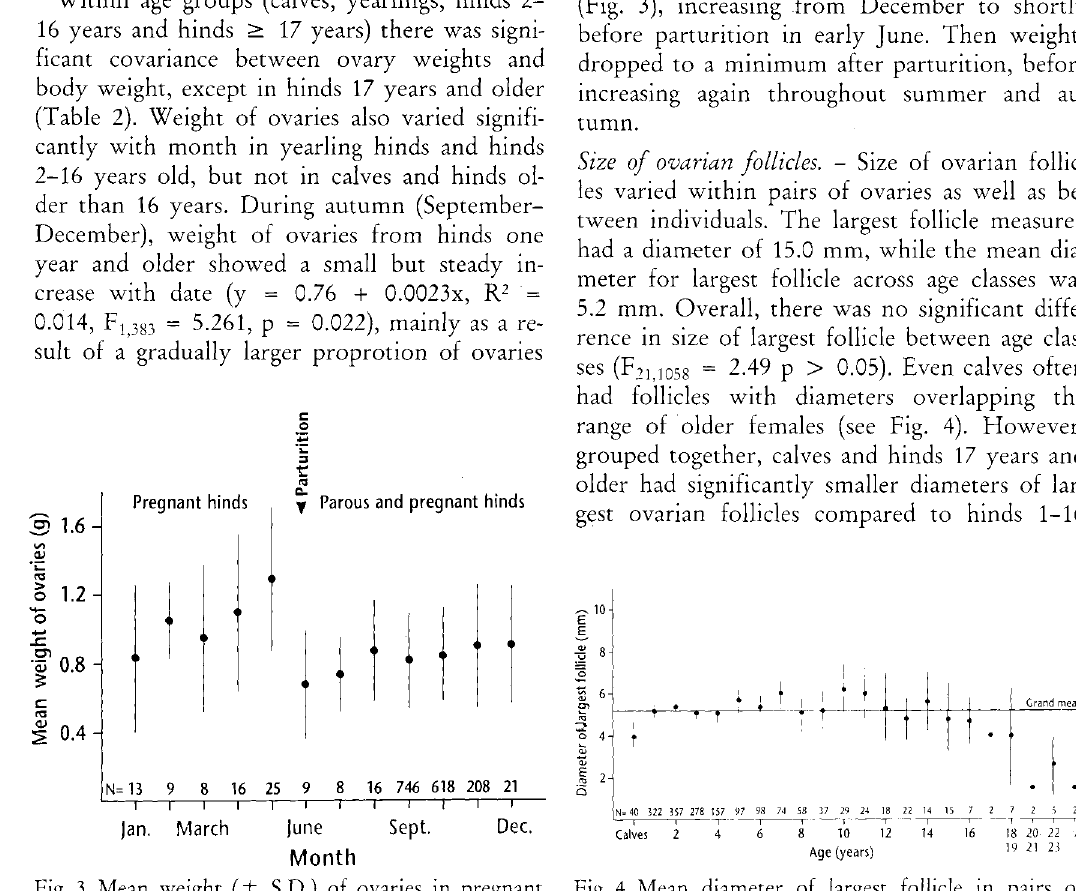
Fig. 3. Mean weight (± S.D.) of ovaries in pregnant or parous hinds one year and older in diffe rent months of the year.